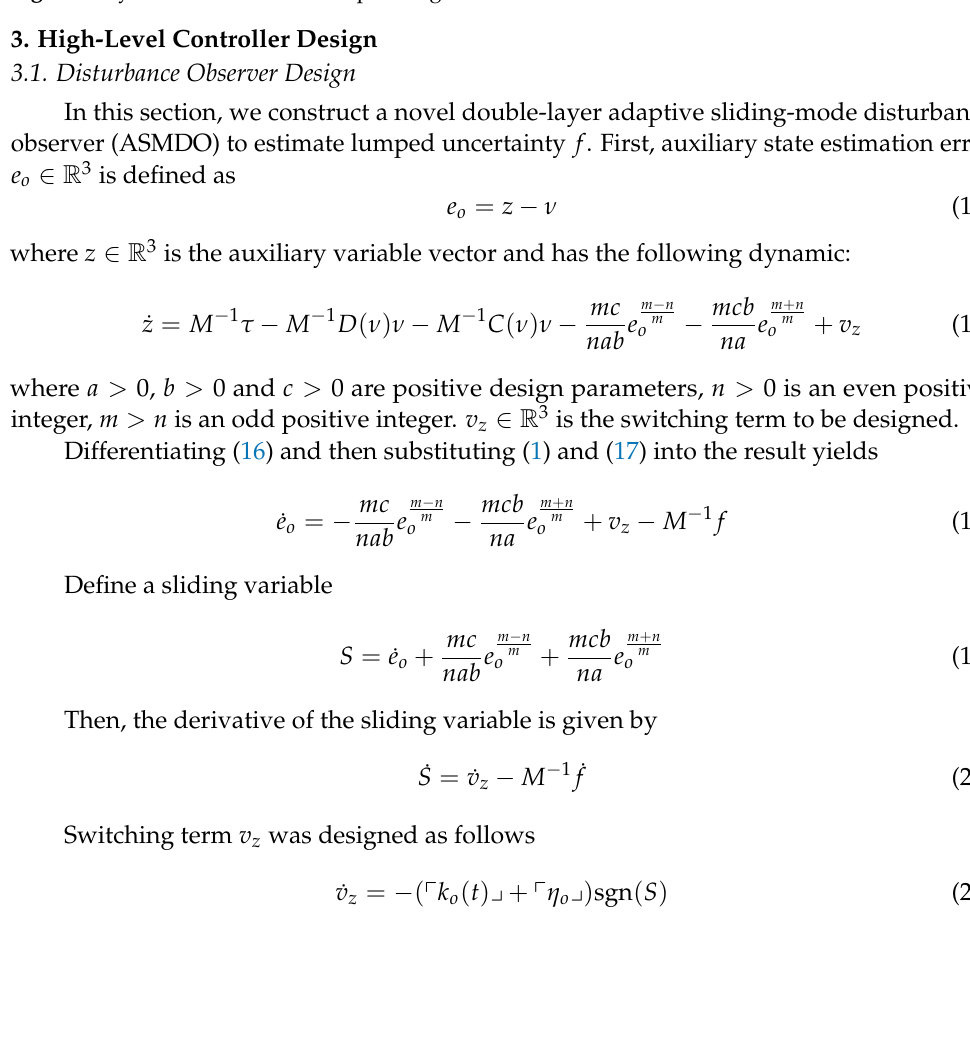
Figure 1. System architecture incorporating control